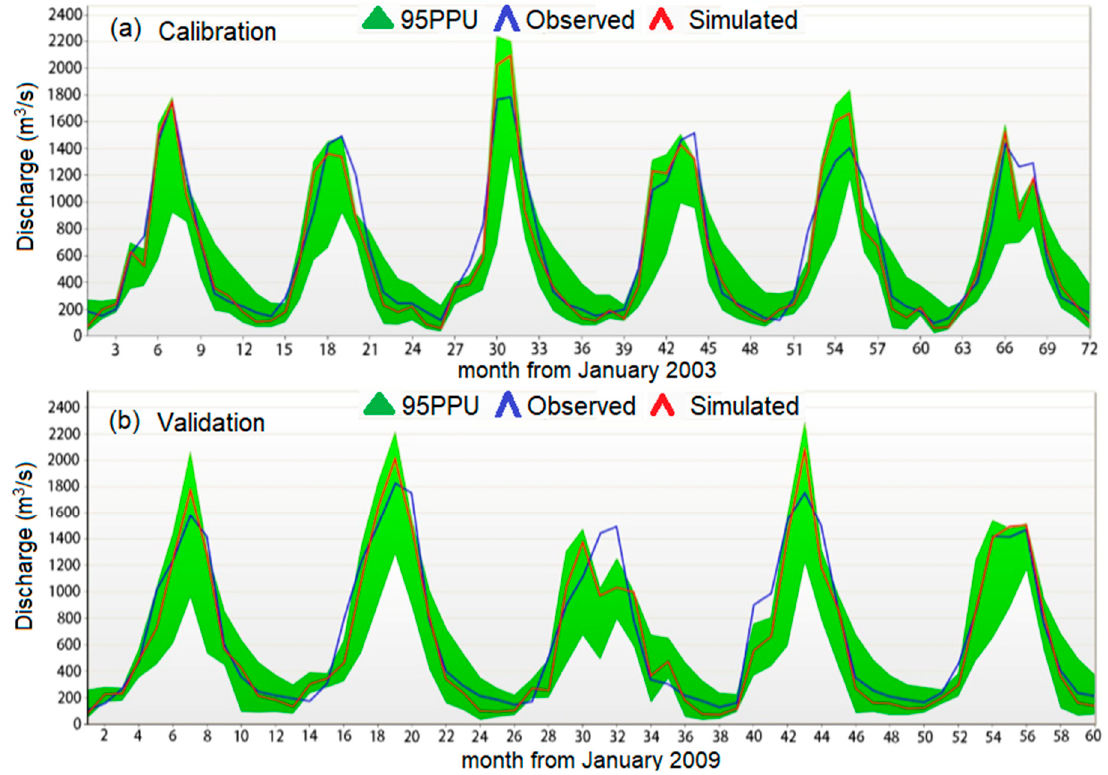
Figure 9. ( a ) Monthly calibration (2003–2008) and ( b ) validation (2009–2013) with the elevation band (EB) method in the application of the SWAT–CUP tool at the Darband discharge station in the Vakhsh River Basin in Central Asia. The observed discharge data (blue lines) are presented along with the prediction uncertainty (green range) and a set of 1000 simulations (red lines). 95PPU: 95% prediction uncertainty. Table 4. The statistics of a comparison of the observed monthly and daily calibration and validation data for the SWAT model with the simulation band based on the p-factor and r-factor at the Darband discharge gauging station in the Vakhsh River Basin (VRB), used to estimate the model performance. NSE: Nash–Sutcliffe efficiency; R 2 : coefficient of determination; PBIAS: percentage bias; MSE: mean square error; RSR: root-mean-square error standard deviation ratio.